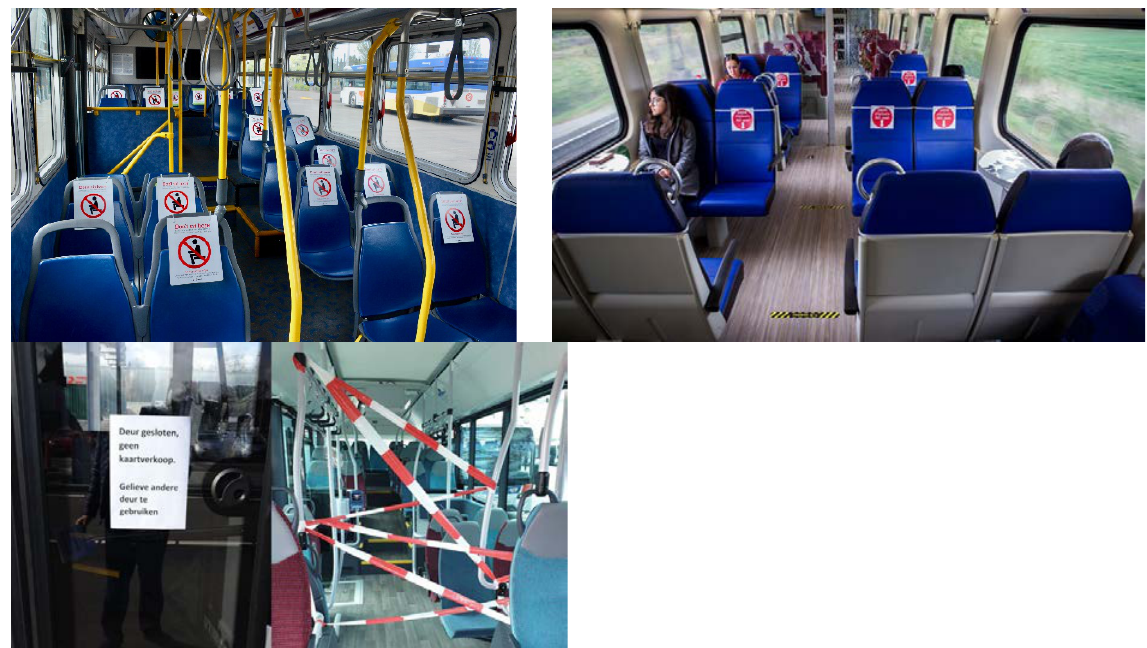
Figure 1. Seats marked during covid19: TriMet bus 8 (top left), NS intercity train 9 (top right), RET bus 10